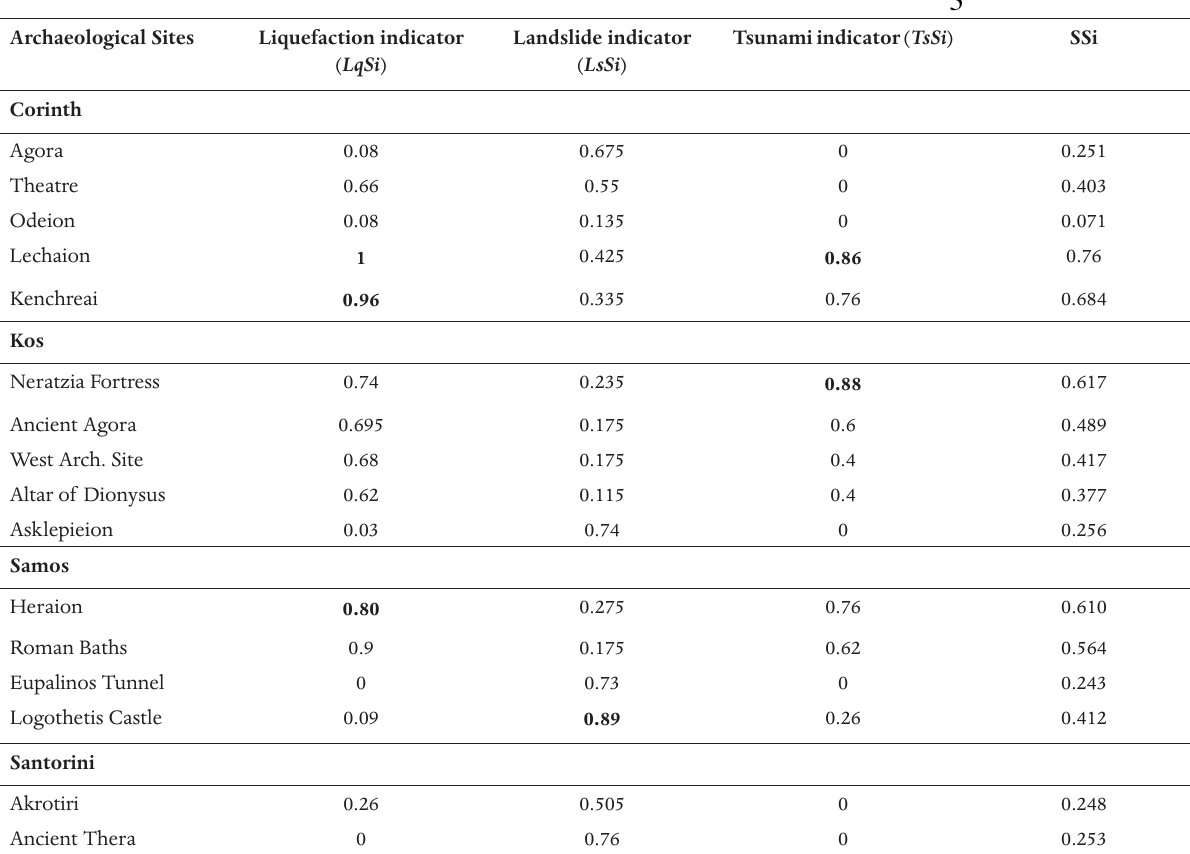
Table 4. Regional distribution of the Spatial Susceptibility index for the archaeological sites under study. Sites under very high susceptibility to EEEs in